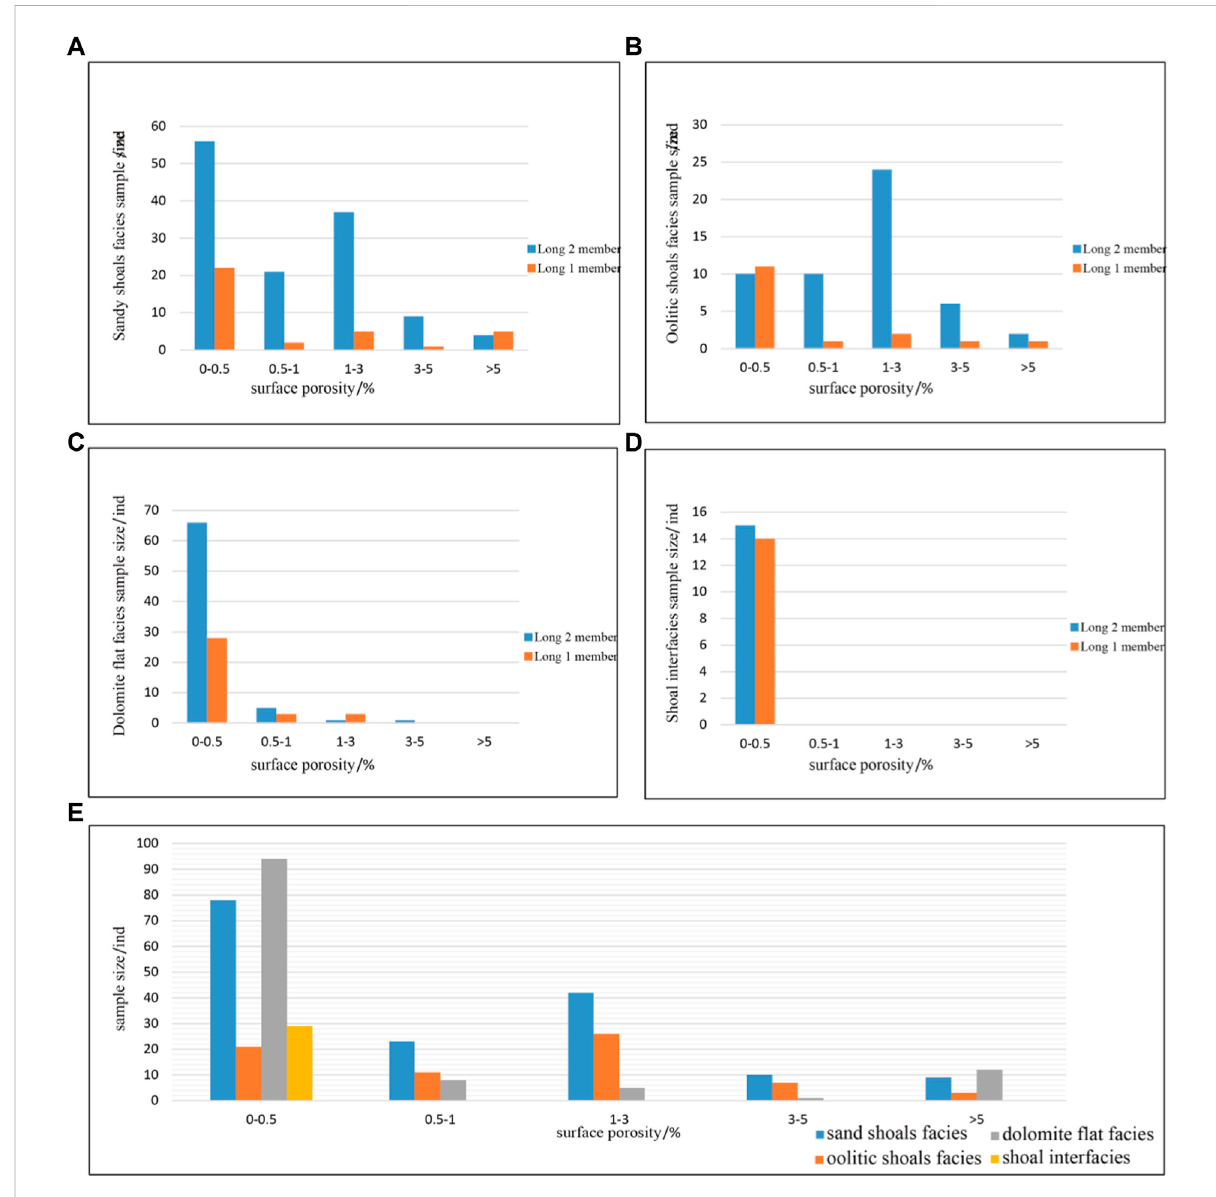
FIGURE 7 Histogram of surface porosity distribution of various lithofacies of the Longwangmiao Formation in the study area. (A) Histogram of surface porosity distribution of sandy shoals facies; (B) Histogram of surface porosity distribution of oolitic shoals facies; (C) Histogram of surface porosity distributionofdolomite fl atfacies; (D) Histogram ofsurfaceporosity distributionofshoal interfacies; (E) Histogram ofsurfaceporositydistributionin the Longwangmiao Formation.